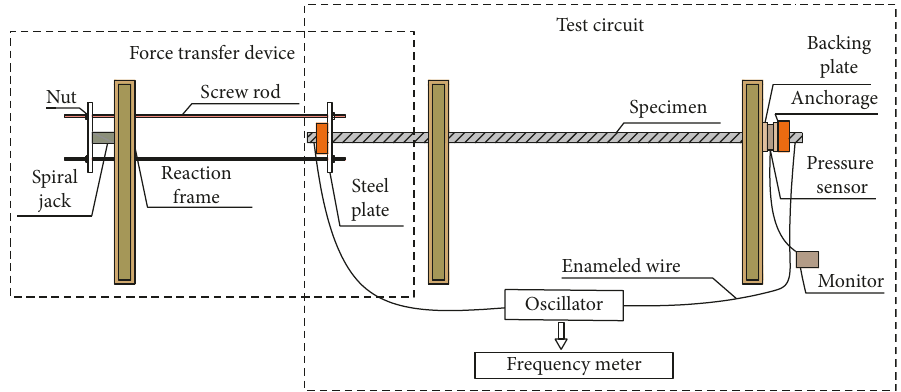
Figure 4: Schematic diagram of the experimental device.